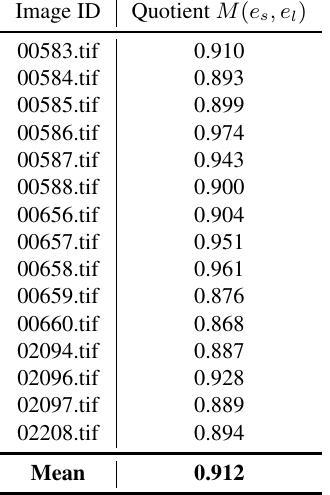
Table 3. Quotient M of semi-minor and semi-major ellipse axis for images under kinematic conditions.